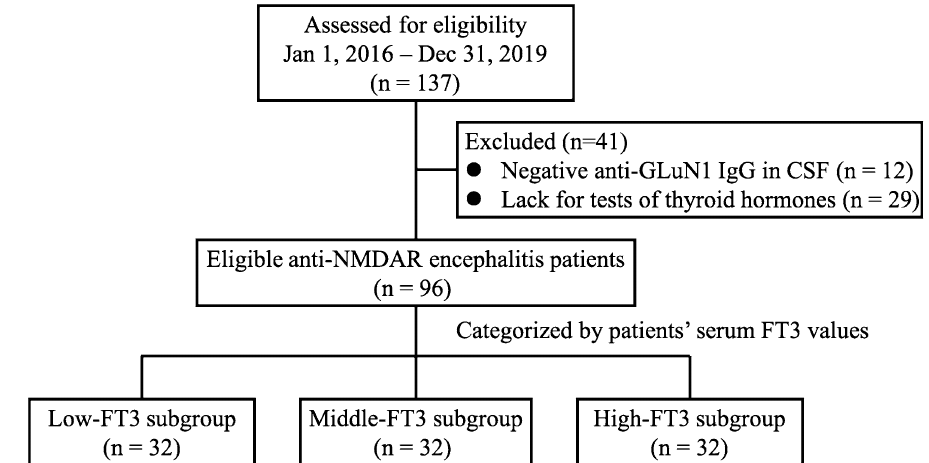
Figure 1. Cohort selection process of the study population. Of 137 admissions for anti-NMDAR encephalitis reviewed, 12 patients were excluded because their IgG anti-GluN1 antibodies were only positive in serum but negative in CSF, which couldn’t meet the diagnostic criteria of definite anti-NMDAR encephalitis. Another 29 patients were excluded for the lack of results of thyroid hormones within 24 h of admission. Ultimately, a total of 96 patients were included in this study. Based on the levels of serum FT3, the patients were equally divided into three subgroups, i.e. the low-FT3, middle-FT3 and high-FT3